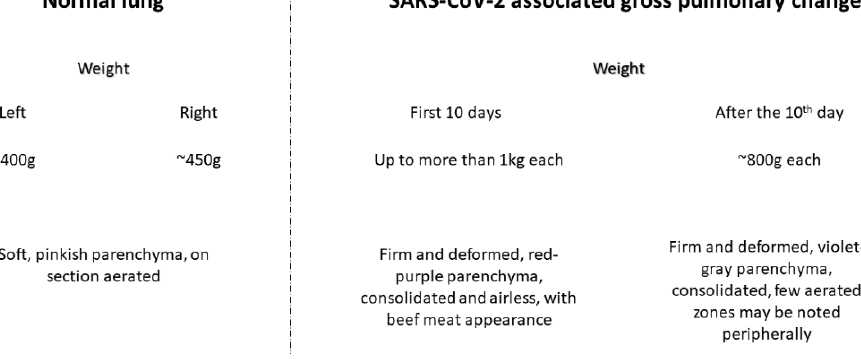
Figure 1. Comparison between gross features of normal lung and SARS-CoV-2 infected lung.